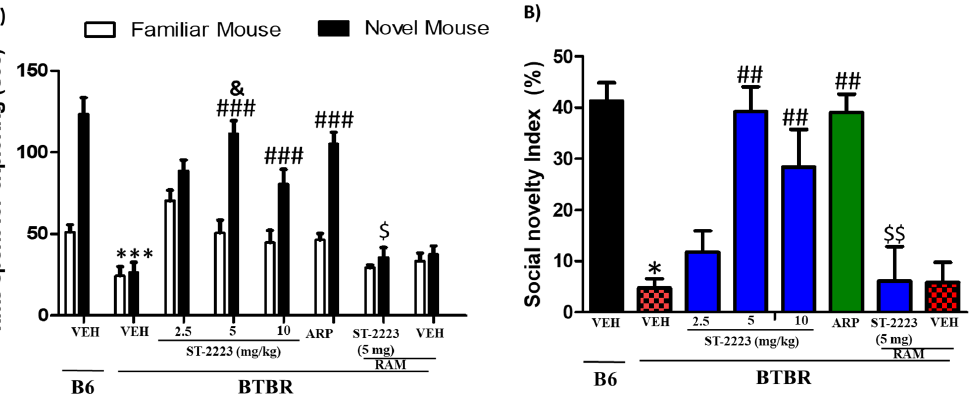
Figure 2. Effects of ST-2223 on social novelty deficit of BTBR mice in social novelty approach test ( A ) B6 and BTBR mice spent time for exploring novel mouse/familiar mouse. ( B ) Social novelty index (SNI). * p < 0.05, *** p < 0.001 compared to VEH-treated B6 mice. ## p < 0.01, ### p < 0.001 compared to VEH-treated BTBR mice. & p < 0.05 compared to ST-2223 at doses of 2.5 and 10 mg/kg. $ p < 0.05, $$ p < 0.01 compared to ST2223-(5 mg)-treated BTBR mice. Data are expressed as the mean ± SEM (n =